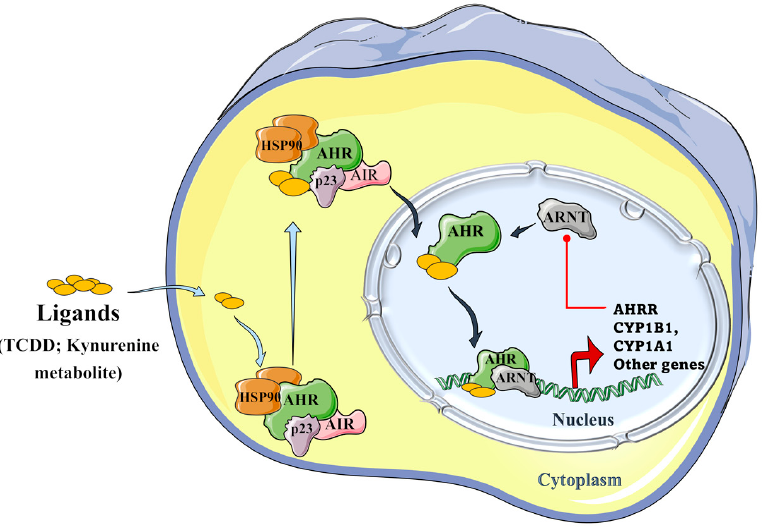
Figure 5. Schematic representation of the aryl hydrocarbon receptor (AHR) signaling pathway. The AHR can form a complex with its ligands (TCCD and kynurenine metabolite), the two heat shock proteins, i.e., HSP90s; with an X-associated protein (AIP), and a molecular chaperone protein, p23 in the cy- toplasm. The formed AHR complex is then able to translocate into the nucleus, where it detaches from chaperone subunits, in order to dimerize with the aryl hydrocarbon receptor nuclear trans- locator (ARNT), and to transactivate the target genes by binding to xenobiotic response elements (XRE) in their promoter regions, where AHR regulates the expression of several groups of genes in the genome, such as CYP1A1, CYP1B1, AHRR, and TiPARP genes. The induced aryl hydrocarbon receptor repressor (AHRR) plays an important role in a negative regulatory step because it can in- hibit the binding of ARNT and AHR and, hence, further transactivation [22–25]. (Figure 5 was partly generated using Servier Medical Art, provided by Servier, licensed under a Creative Commons At- tribution 3.0 unported license). In our study, tissues exposed to IPA treatment and untreated, comparable controls were analyzed using genome-wide RNA sequencing to evaluate the effect of IPA on gene expression. We confirmed that IPA is an inducer of the CYP1A1, CYP1B1, AHRR, and TiPARP genes in the patient-derived tissue slices model, as the overrepresentation and clustering of upregulated genes showed that the AHR pathway was indeed significantly induced. The effect of IPA on TiPARP, CYP1A1, and CYP1B1 mRNA expression was also validated in in vitro conditions. Our result was consistent with the experiment of Reiji Aoki et al., who demonstrated that AHR genes are significantly upregulated in the intes- tinal tract of mice both in vitro and in vivo [12].